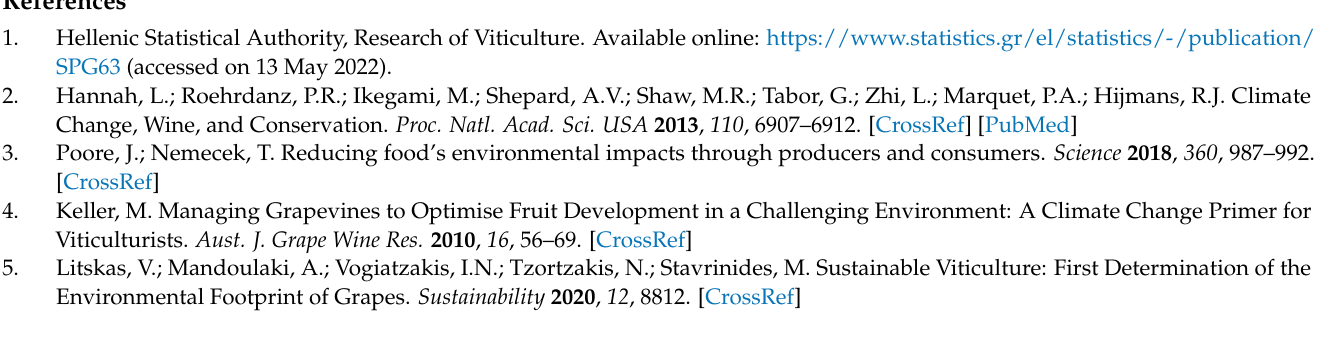
Figure S3: Unsupervised classification using PCA on metabolomic data from grape berries treated with ABA; Figure S4: Unsupervised classification using PCA on metabolomic data from grape berries treated with CHT; Figure S5: Total concentration of polyphenols in Savvatiano berries at middle veraison stage; Figure S6: Total concentration of polyphenols in Savvatiano grape berries at harvest stage; Figures S7 and S8: Expression level of genes involved in phenylpropanoid